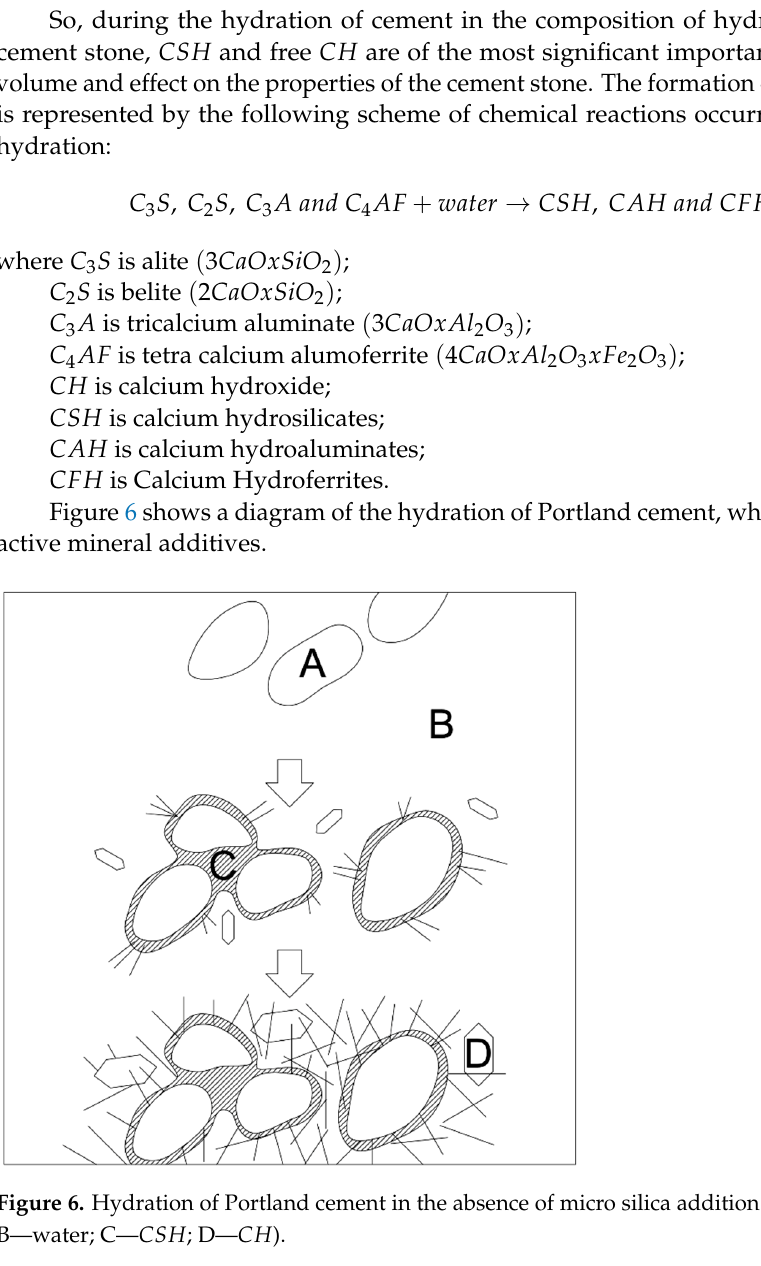
Figure 7. Development of the microstructure of cement stone in the process of hydration of Portland cement, where: Fss— calcium aluminoferrite; AFt—calcium hydrosulfoaluminate; AFm—calcium hydrosulfoaluminoferrite. The addition of silica fume binds free CH into less soluble and denser compounds, which makes it possible to reduce the thickness and increase the density of the transition zone in concrete. Therefore, due to this pozzolanic reaction, the content of free ( ) 2 Ca OH in the form of large crystals of portlandite decreases, while the content of CSH increases, increasing the strength and durability of concrete by increasing the density and strength of both the cement stone itself and the contact zone between cement stone and aggregate grains in the structure of high-strength concrete. Using the method of electron microscopy, a comparative analysis of the effect of mi- cro silica and a complex of micro silica (MS) + superplasticizer (SP) on the formation of